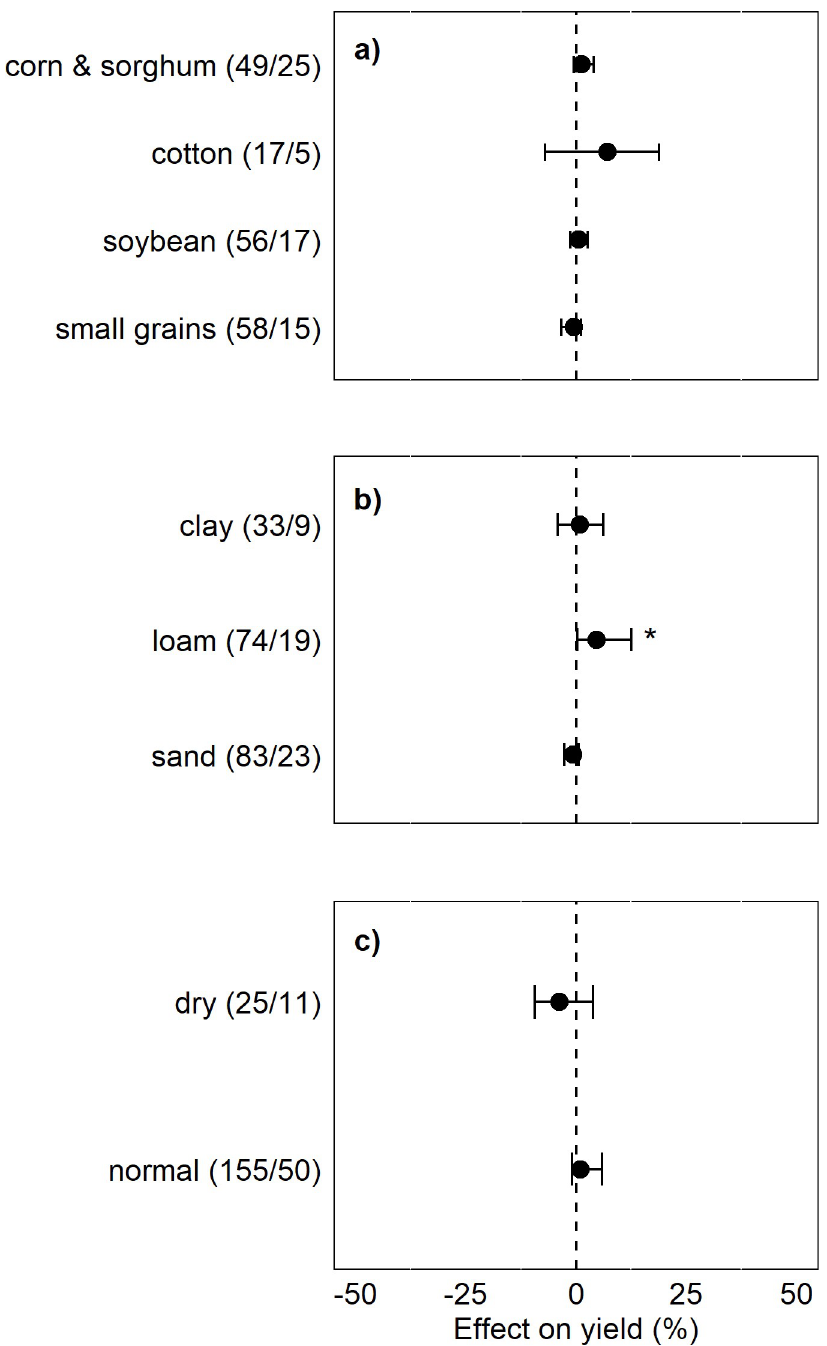
Fig 5. Effect of ICLS on crop yield relative to unintegrated systems within subgroups for (A) crop type, (B) soil texture, and (C) during dry or normal precipitation years. Excludes observations from dual-purpose cropping systems. Number of observations/number of studies for each category appears in parentheses. Categories with less than 15 observations were omitted from the subgroup analysis, as were observations from dual-purpose cropping systems. Points represent grazed system yield effect, while the dotted vertical line represents the paired ungrazed system yield. Error bars represent 95% bias-corrected-accelerated bootstrap confidence intervals. Asterisks ( � ) represent a significant yield response in grazed systems relative to ungrazed systems at the 95% confidence